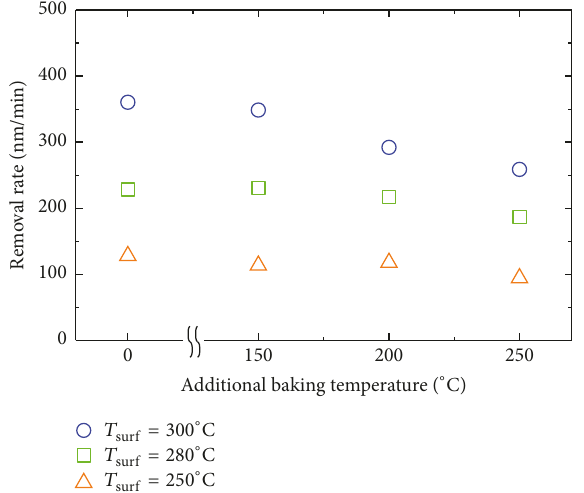
Figure 3: The removal rate as a function of the additional baking temperature when the surface temperatures were 250, 280, and 300 ∘ C,